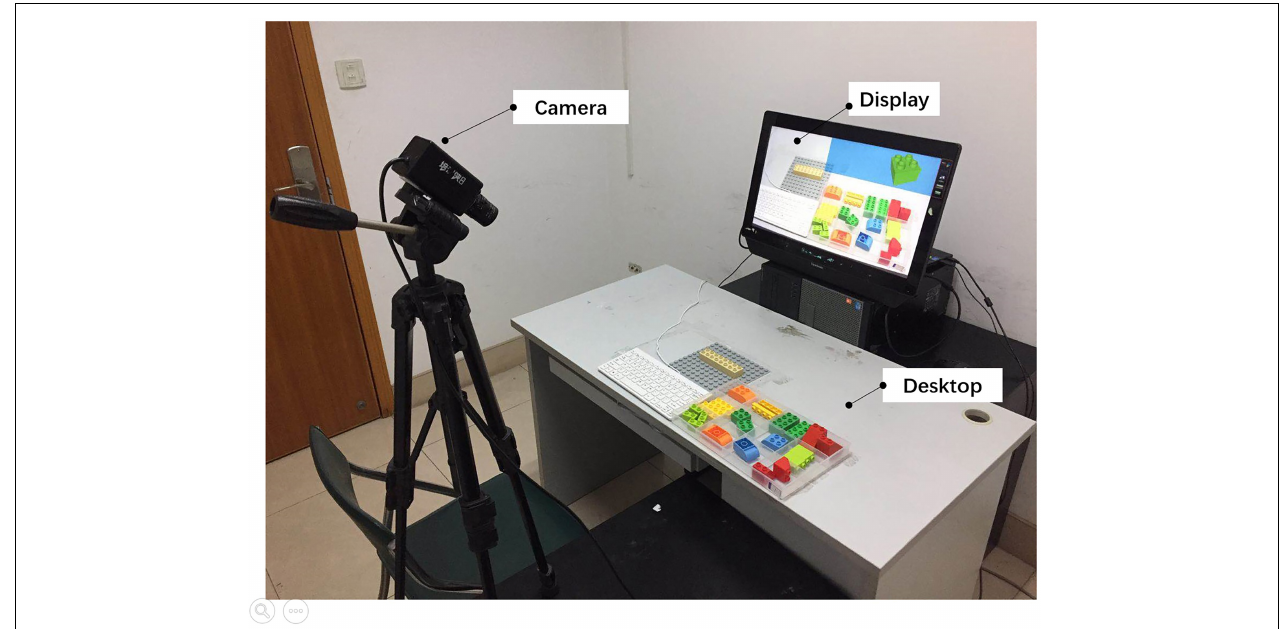
FIGURE 2 | Experimental